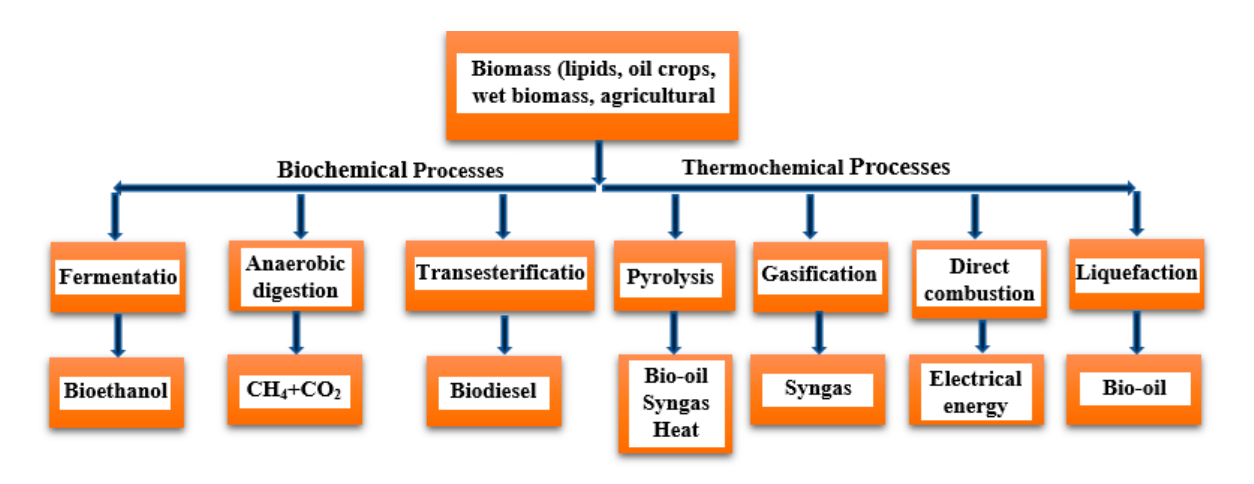
Figure 7. Jordan’s electricity requirements between 2015 and 2050.